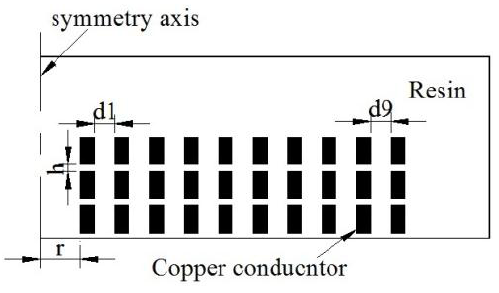
Figure 5. Structure schematic diagram of the flat spiral coil.